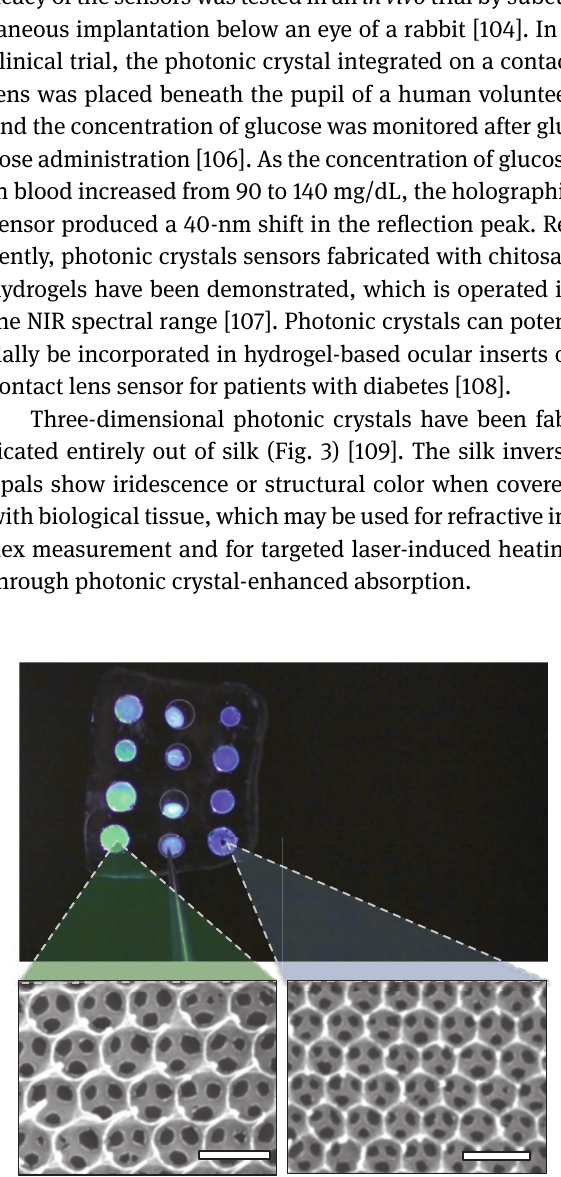
Fig. 3. Silk inverse opals showing structural color. Reprinted by permission from [109], Copyright 2012, Macmillan Publishers Ltd.